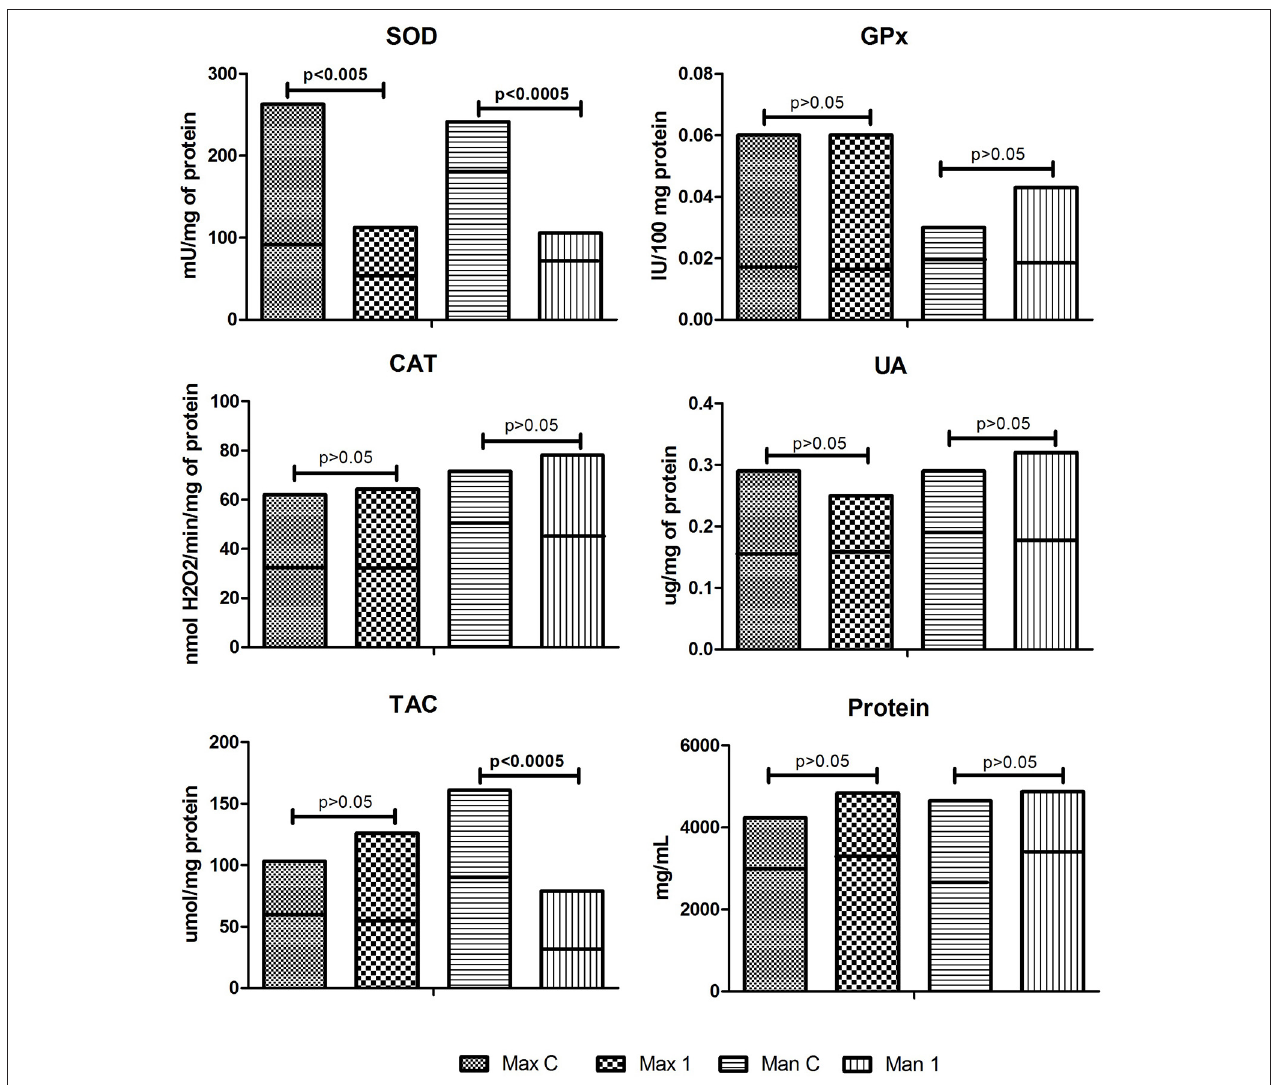
FIGURE 2 | Enzymatic and non-enzymatic antioxidants and protein concentration in the control and examined tissue homogenates. Max C, maxilla control; Man C, mandibula controll; Max 1, maxilla of the study group; Man 1, mandibula of the study group; SOD, superoxide dismutase, GPx, glutathione peroxidase, CAT, catalase, UA, uric acid, TAC, total antioxidant capacity. Horizontal line on the chart indicated the median.